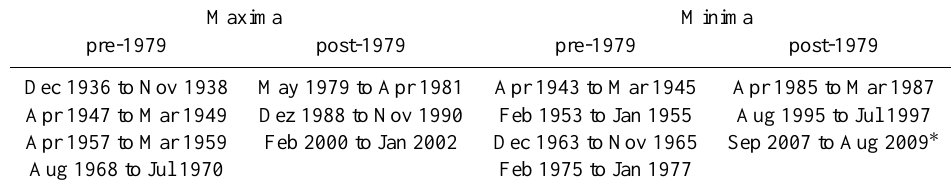
Table 2. Definition of periods of solar maxima and